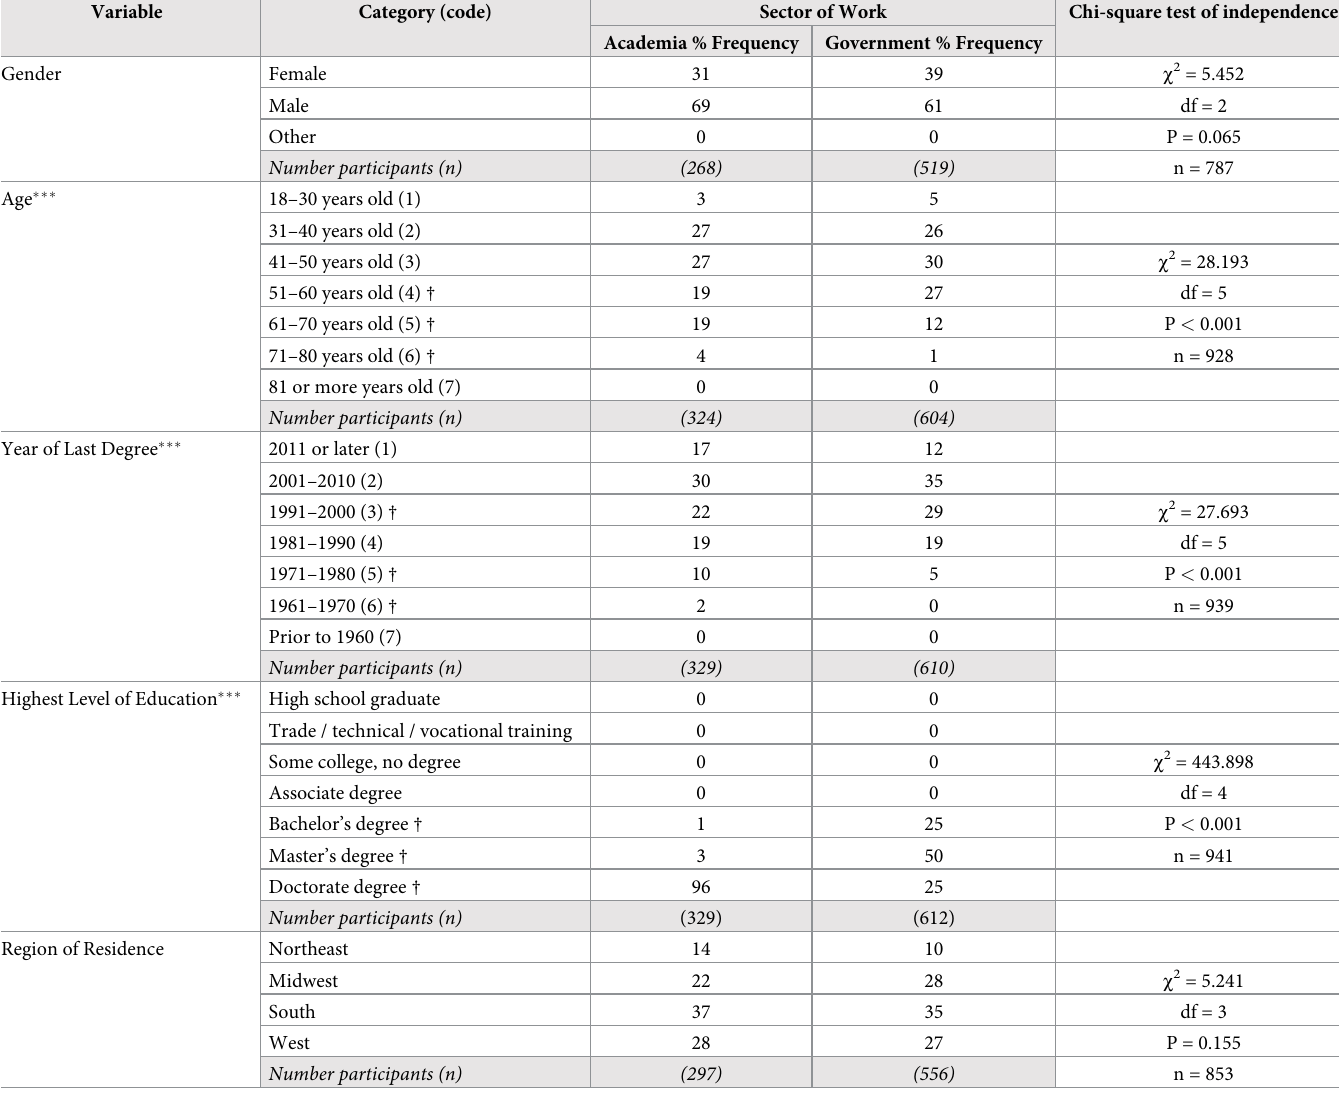
Table 1. Demographic characteristics of survey participants.